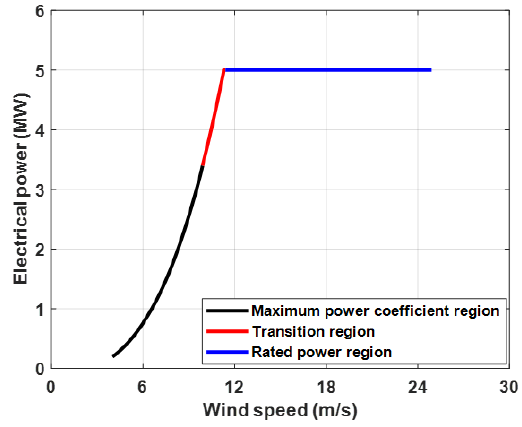
Figure 2. The power curve of the target wind turbine.